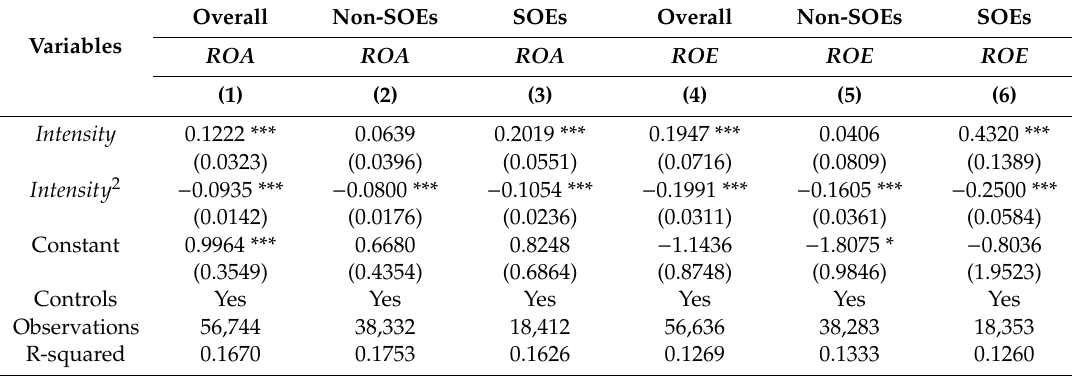
Table 5. The Influence of ESI on Enterprise Performance.